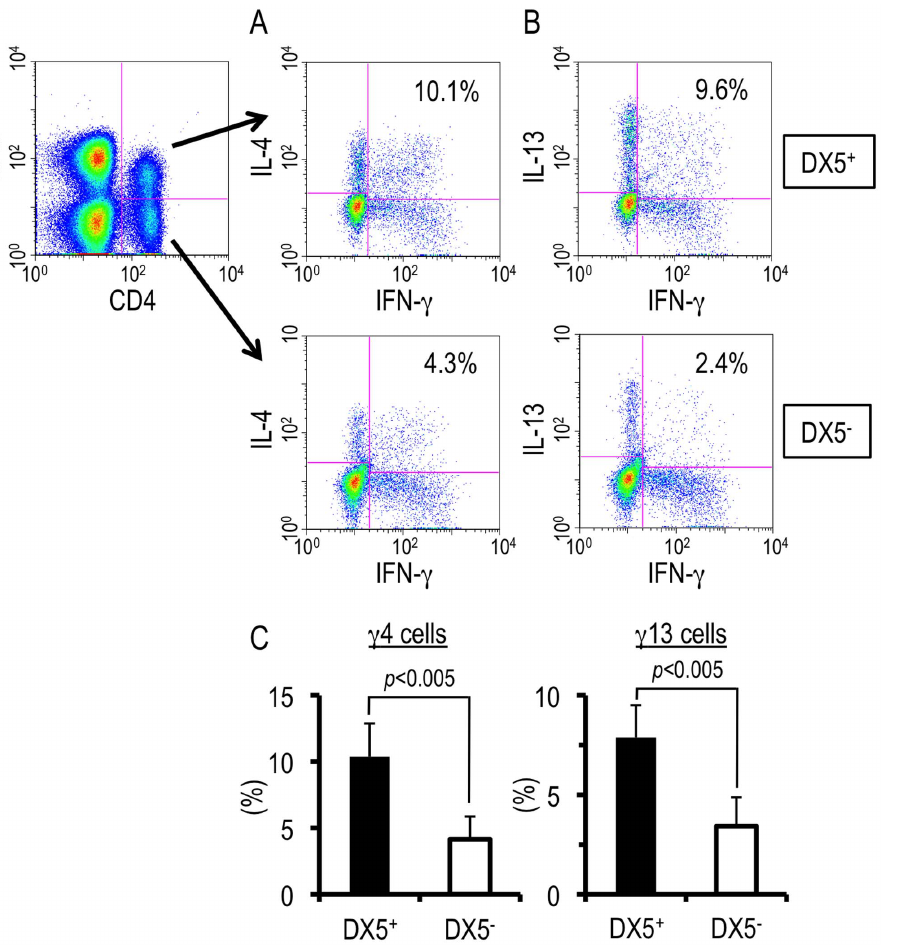
Figure 7. DX5-negative as well as –positive cells displayed the unique cytokine production patterns. (A and B) Hepatic lymphocytes were isolated from S. mansoni -infected mice and flowcytometric analysis was conducted upon TCR ligation at 6 weeks PI. The numbers in the insets represent percentages of c 4 (A) or c 13 (B) cell population in CD4 + DX5-positive or -negative population. This experiment is representative of five independent experiments. (C) Data represent the mean + SD of five independent